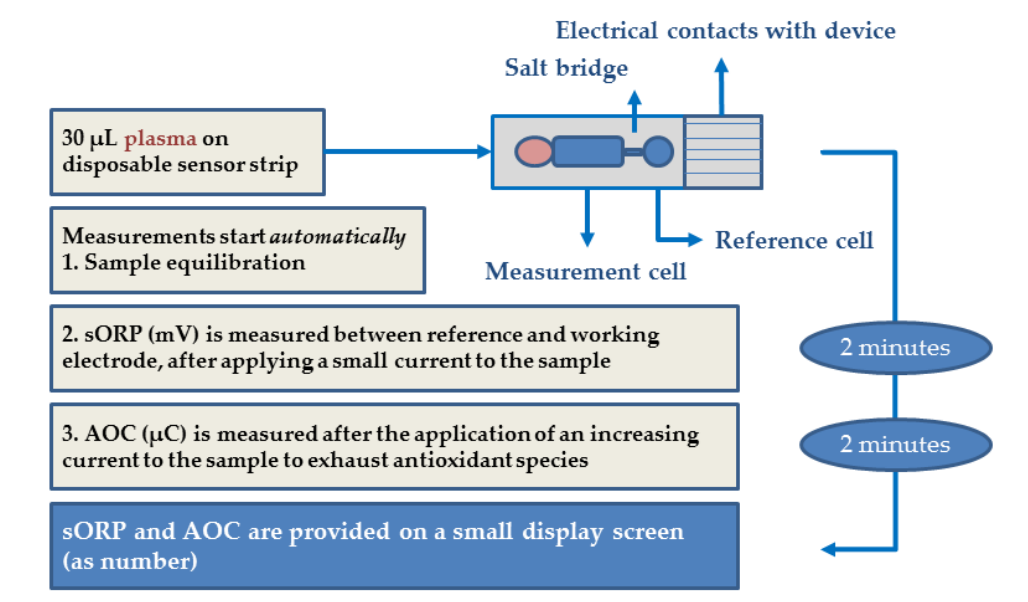
Figure 1. Graphic representation of the methodological process.